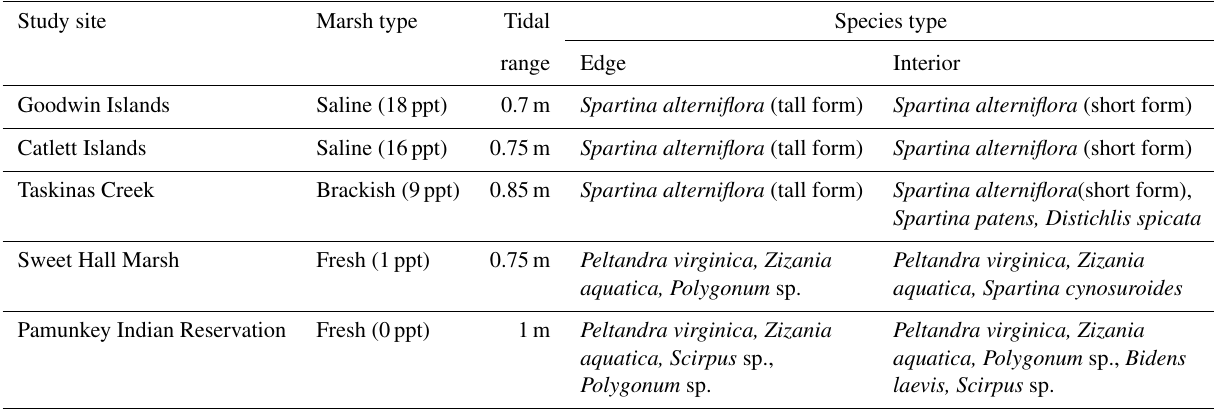
Figure 1. (a) Map of the York River estuary study area, highlighting specific study site locations and their salinities. Average channel salinities are from Reay (2009). (b) Elevation profile for each study site where elevation is relative to NAVD (North American Vertical Datum). Blue shading indicates the location of the marsh edge and the interior sampling locations. Table 1. Ecological and physical characteristics of the five selected sites for this study. Salinity data are average channel salinities from Reay (2009). Tidal range data are from Friedrichs (2009) and Sisson et al. (1997). Species data are from aboveground biomass samples collected for this